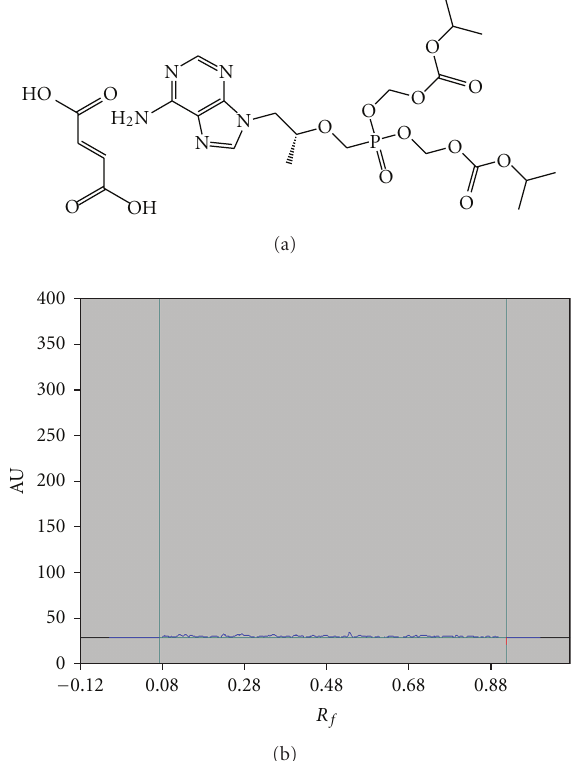
Figure 1: (a) Chemical structure of tenofovir disoproxil fumarate. (b) Representative chromatogram obtained for the